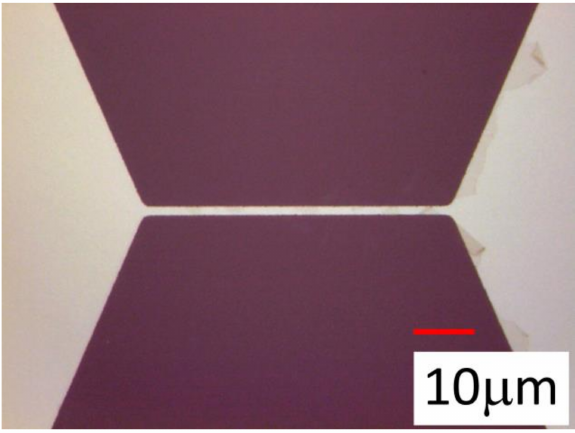
Figure 9. Photograph of the rectangle pattern on the sensor. The design was 2 µ m wide and 50 µ m long.